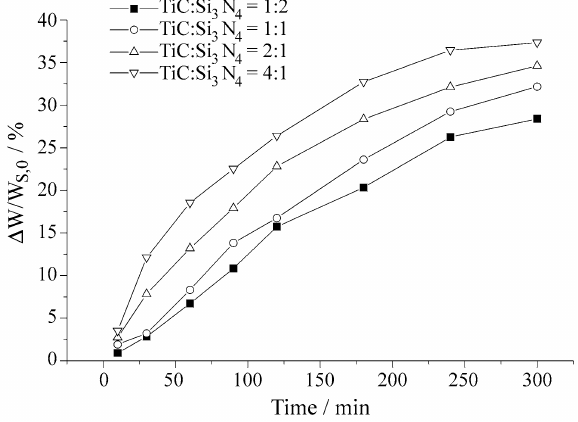
Figure 5. Weight losses of the TiC-Si 3 N 4 mixtures with various ratios of the components during heat treatment at 1700 °C vs. heat treatment time.